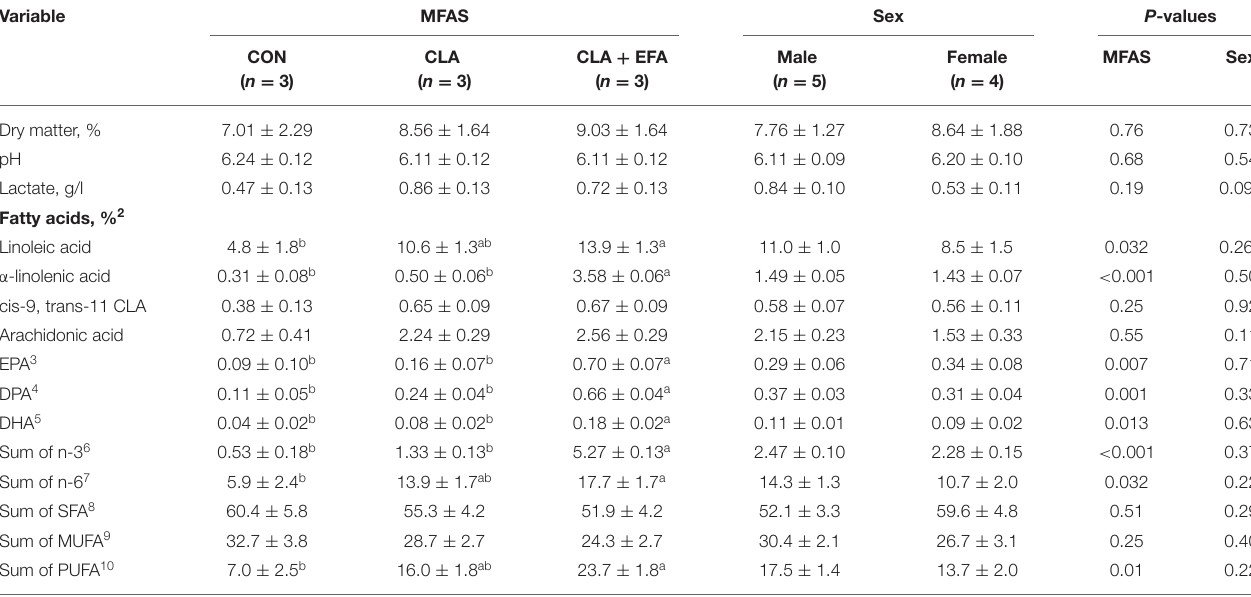
TABLE 1 | Physico-chemical characteristics of jejunal content depending on maternal fatty acid supply (MFAS) 1 (LSM ± SE).